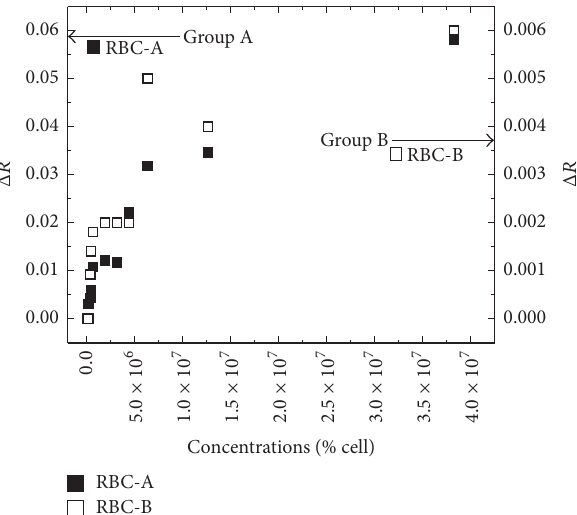
Figure 8: LR-SPR reflectivity change after sensing with various concentrations of red blood cells